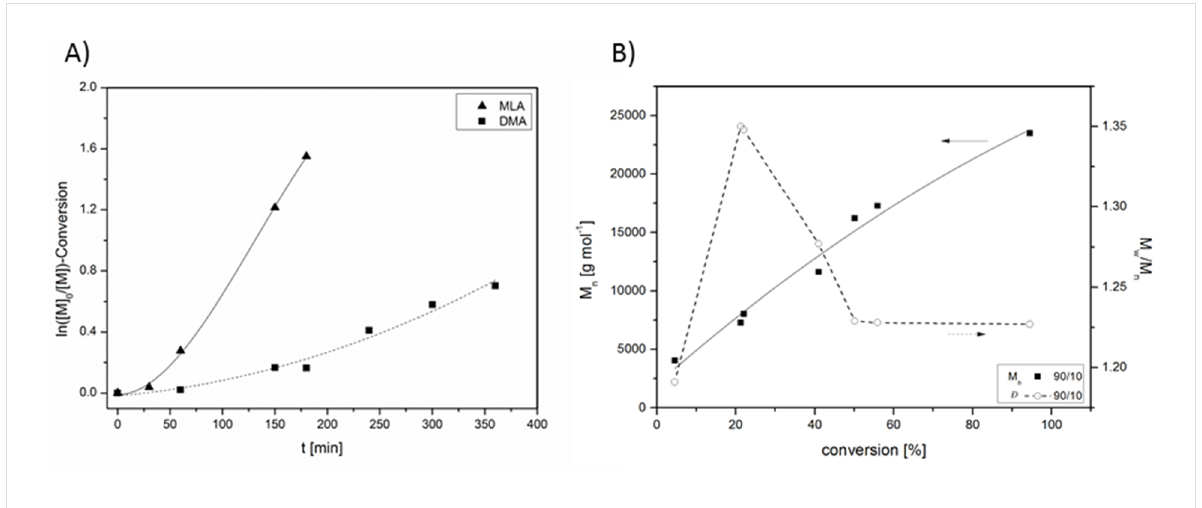
Figure 10: A) Kinetic plot for the RAFT copolymerization of MLA and DMA for the ratio 90/10 employing EMP. B) The evolution of M n (full symbols) and Đ (empty symbols) with conversion of the copolymerization.